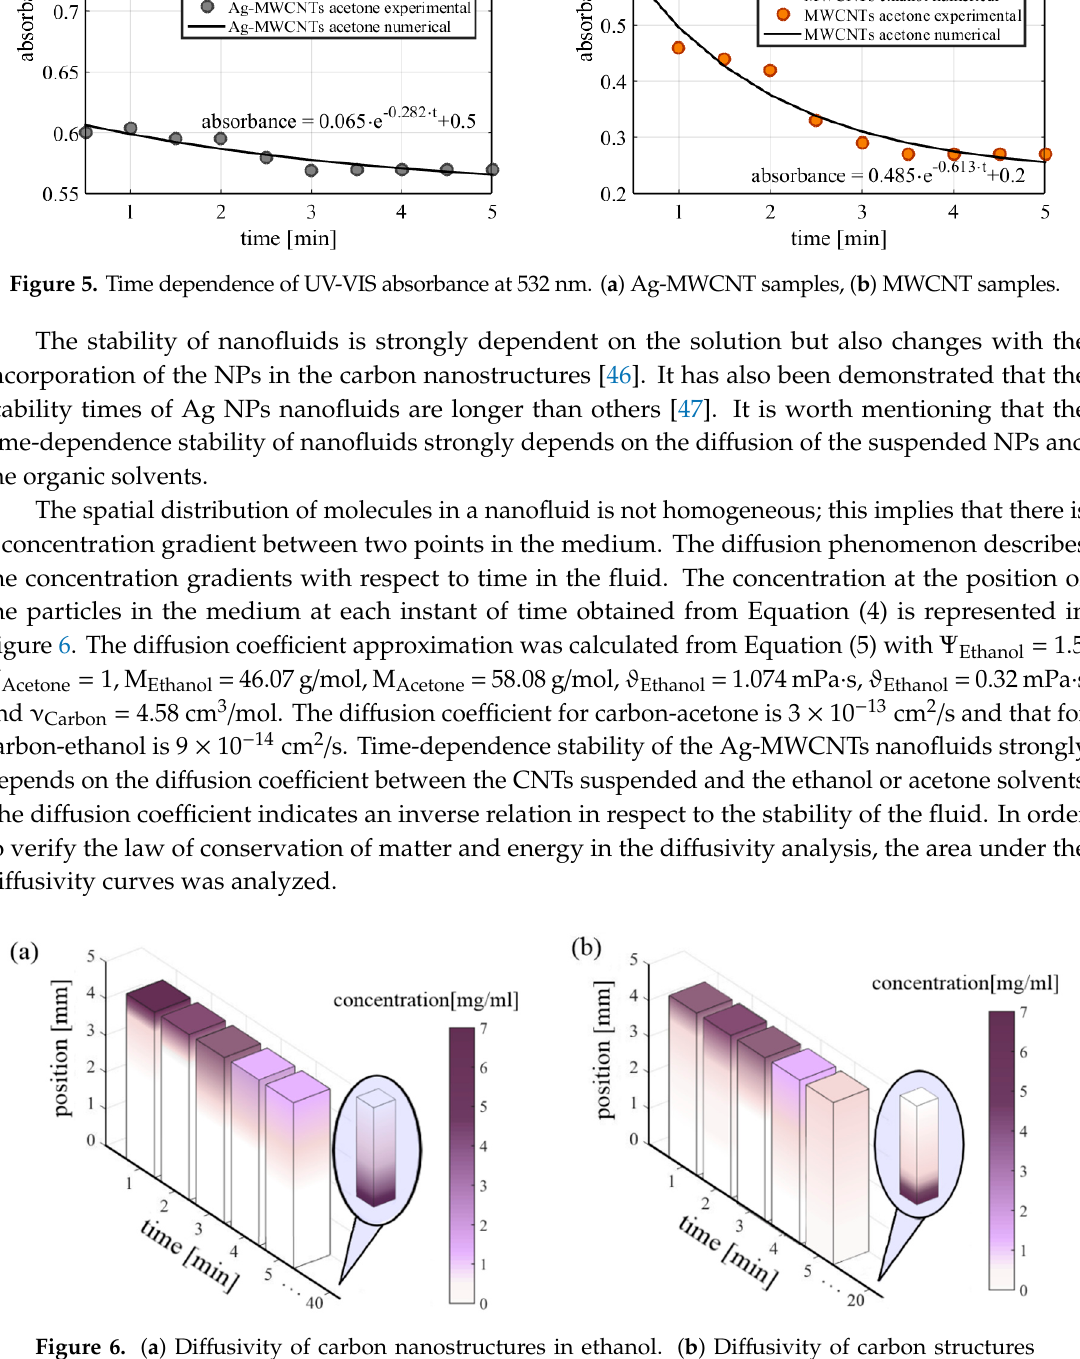
Figure 6. ( a ) Diffusivity of carbon nanostructures in ethanol. ( b ) Diffusivity of carbon structures in acetone.